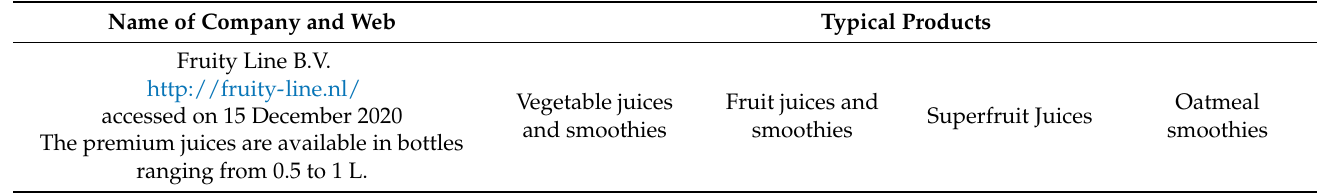
Table A5. High pressure treated products by the company Fruity Line.